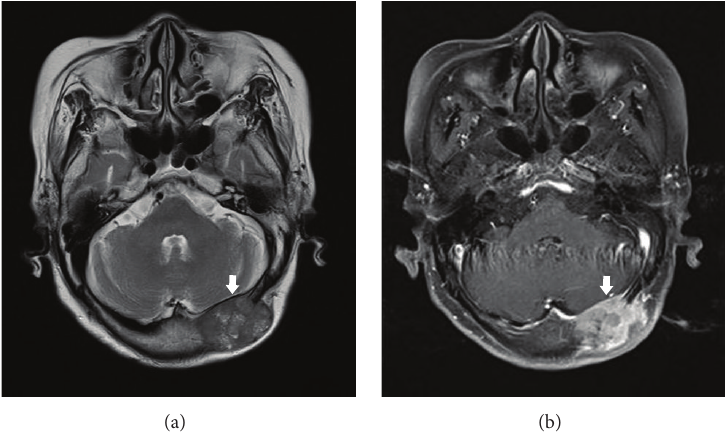
Figure 3: (a) T2W and FLAIR axial image. (b) T1W axial image with Gd-DTPA. Relatively well-defined lobulating, enhancing skull mass in left occiput ( 3.5 × 2.5 cm), with destruction of bone and intracranial extension compressing adjacent sinus, but no definite brain